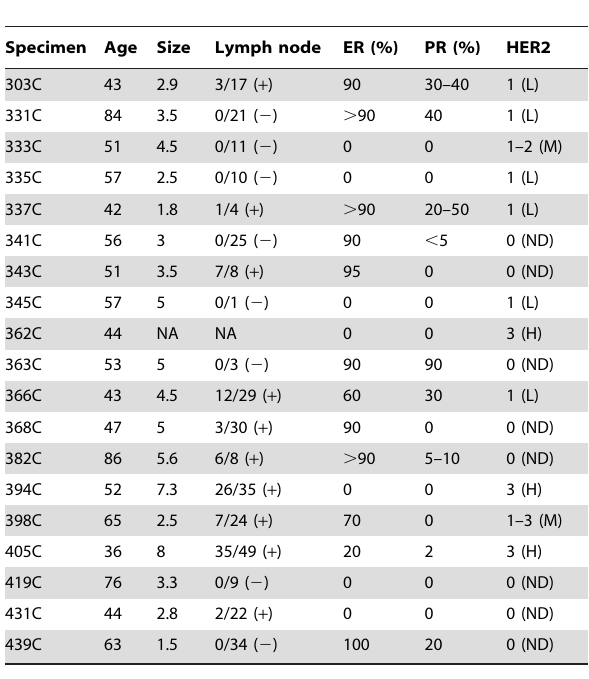
Table 4. Pathology data of the human breast cancer specimens